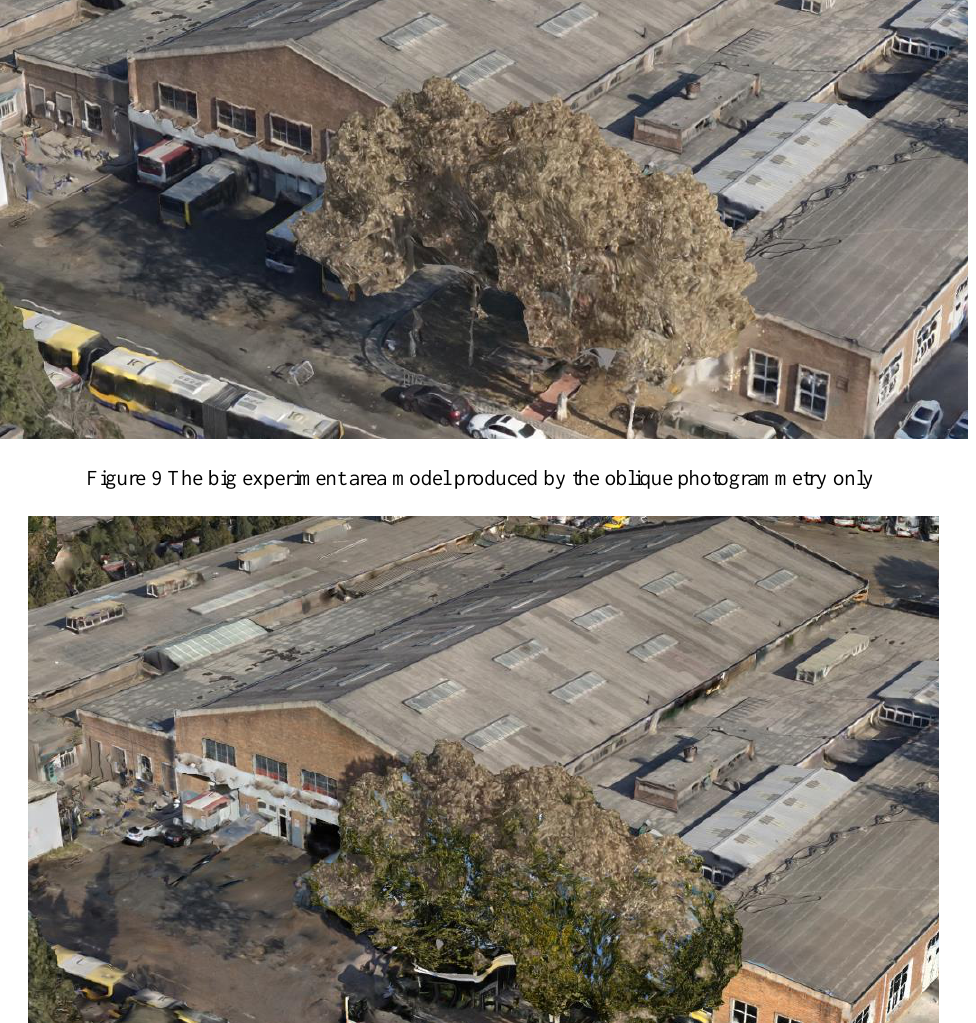
This contribution has been peer-reviewed. The double-blind peer-review was conducted on the basis of the full paper. https://doi.org/10.5194/isprs-annals-IV-3-97-2018 | © Authors 2018. CC BY 4.0